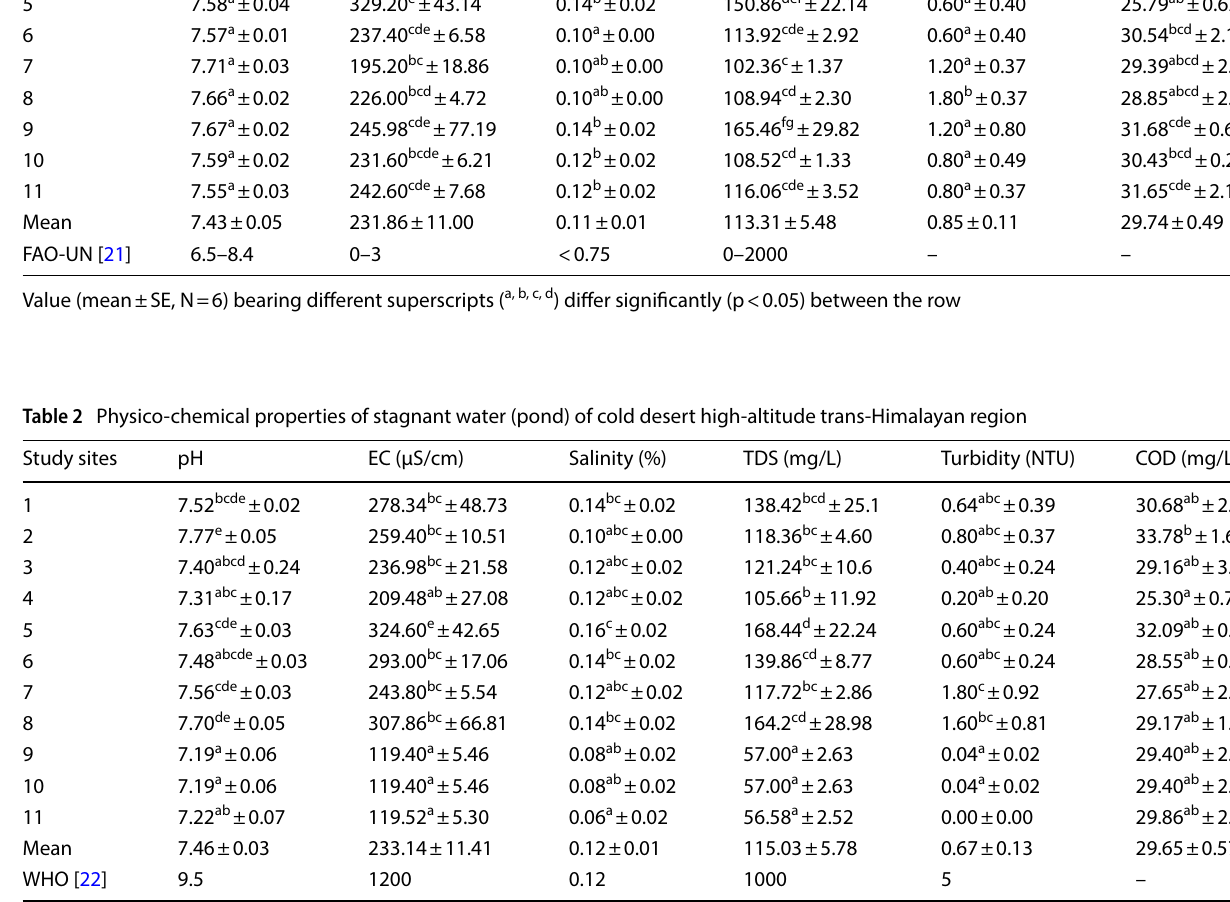
Value (mean ± SE, N = 6) bearing different superscripts ( a, b, c, d ) differ significantly (p < 0.05) between the